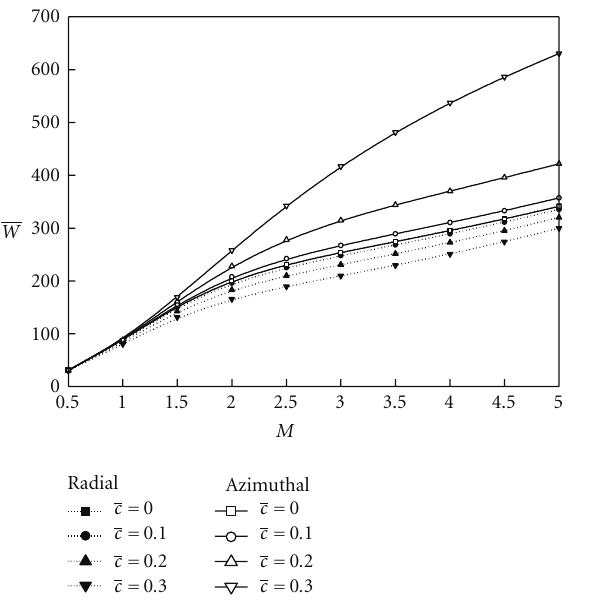
Figure 10: Variation of nondimensional response time t with 1 − h m for di ff erent values of M with β = 0 . 05, l = 0 . 3, c = 0 . 3, and ψ = 0 . 01.